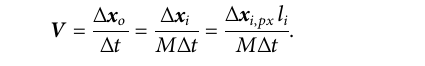
Table 1, where basic information on fl ow regimes, adopted PIV